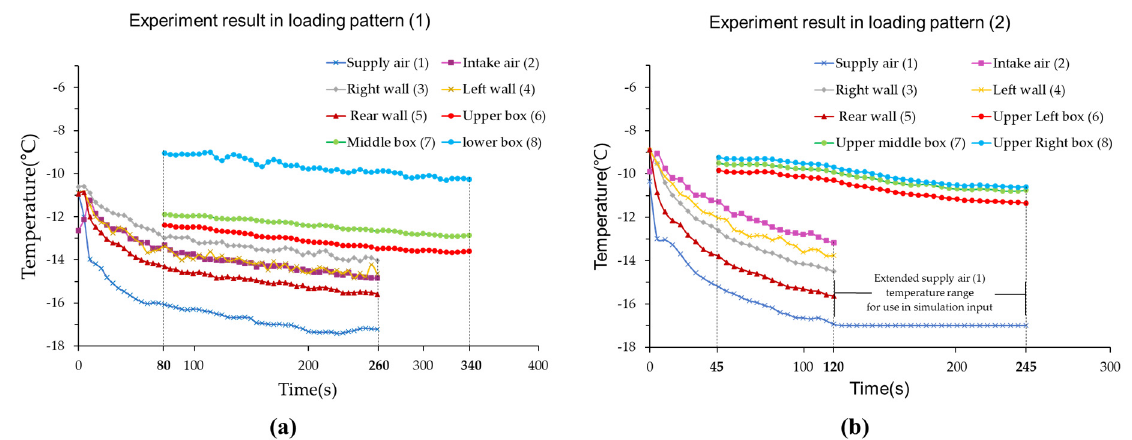
Figure 6. Temperature change in the refrigerated body when refrigeration systems were operating: ( a ) Temperature change by point in the operating cycle in the experiment with loading pattern (1), ( b ) Temperature of the supply air used in simulation with loading patterns (2). Table 1. The lower temperature limits of measurement points (setting temperature: − 15 °C). Point